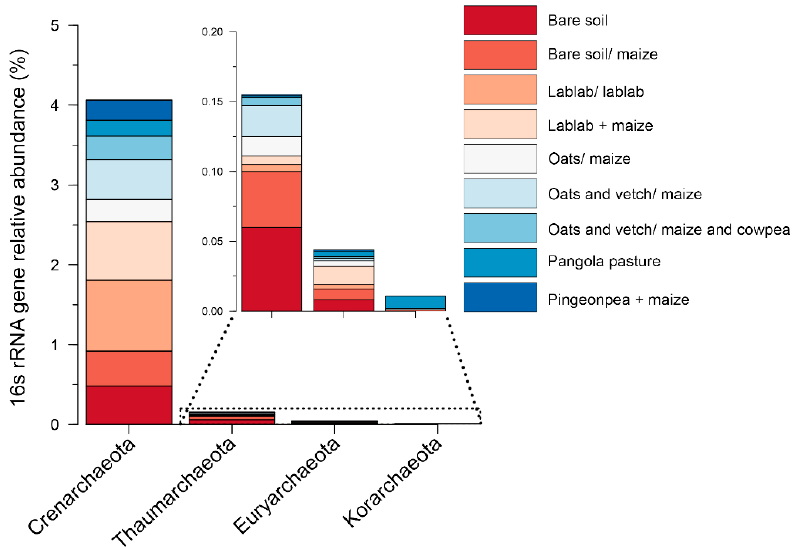
Figure 2. Relative abundance of archaeal 16S rRNA partial gene from agricultural no-tilled soil under eight different cropping systems, showing that Crenarchaeota was higher were lablab was planted, and that Thaumarcheota was higher in the bare soil.